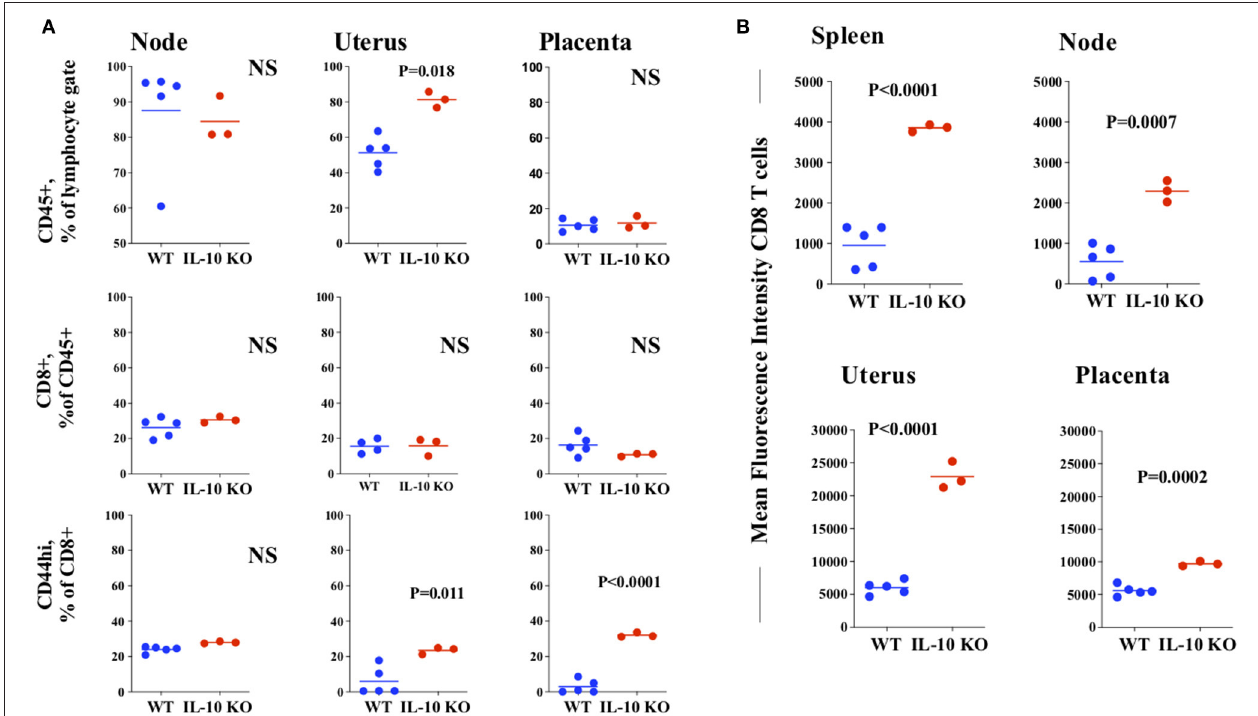
FIGURE 5 | Flow cytometric analysis of tissues from infected normal and IL-10 deficient mice. Single cells suspensions were obtained from tissues harvested from LCMV-infected pregnant WT (blue symbols) and IL-10 KO (red symbols) mice 8 days after infection on ∼ 18 of gestation. Each symbol represents a single tissue from a unique mother. These were stained with antibodies to CD45, CD8, CD44 and PD1 (A) Top panel, percentage of lymphoid gate (by side and forward scatter) cells positive for CD45; Middle panel, percentage of CD45 + cells observed to be CD8 + ; Bottom panel, percentage of CD8 + cells highly expressing CD44 consistent with activation. (B) Expression of PD1 on CD8 + cells in each of the tissues assayed. Lines, means. p values indicate analysis by t test. NS, not significant at the p < 0.05 level, Node: uterine draining lymph